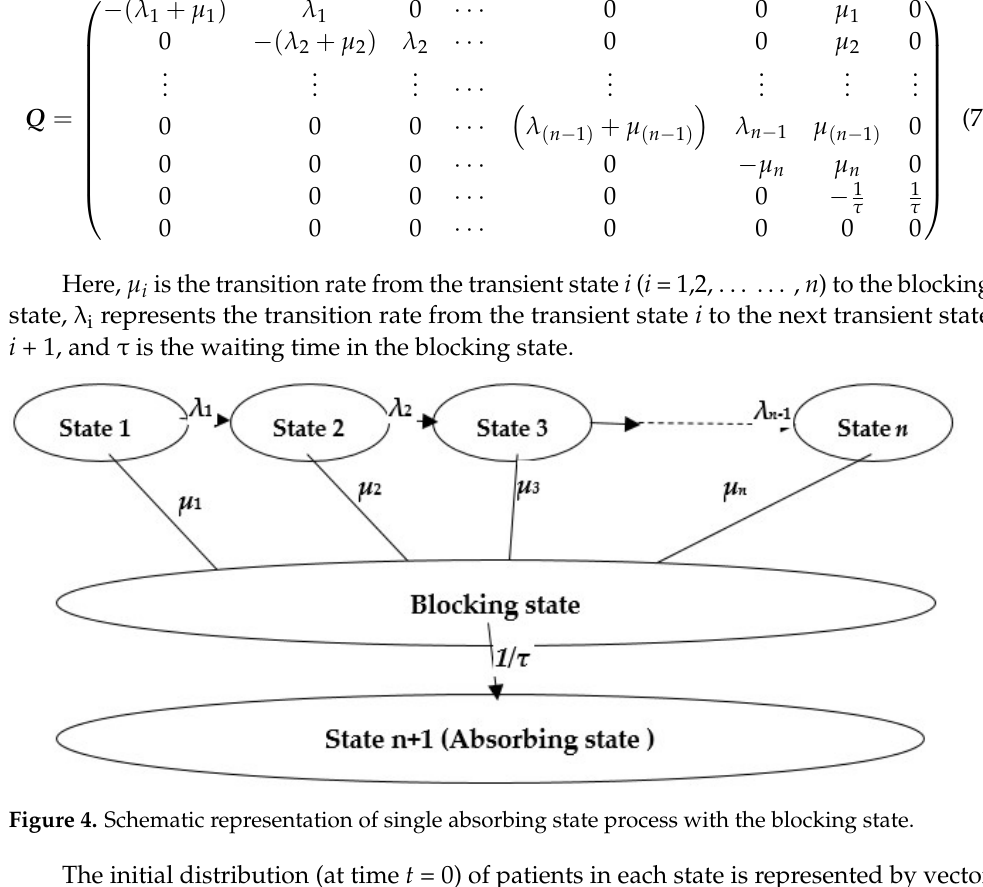
where s 0, i is the initial (at t = 0) number of patients in state i . s 0, n +2 represents the initial number of patients in the absorbing